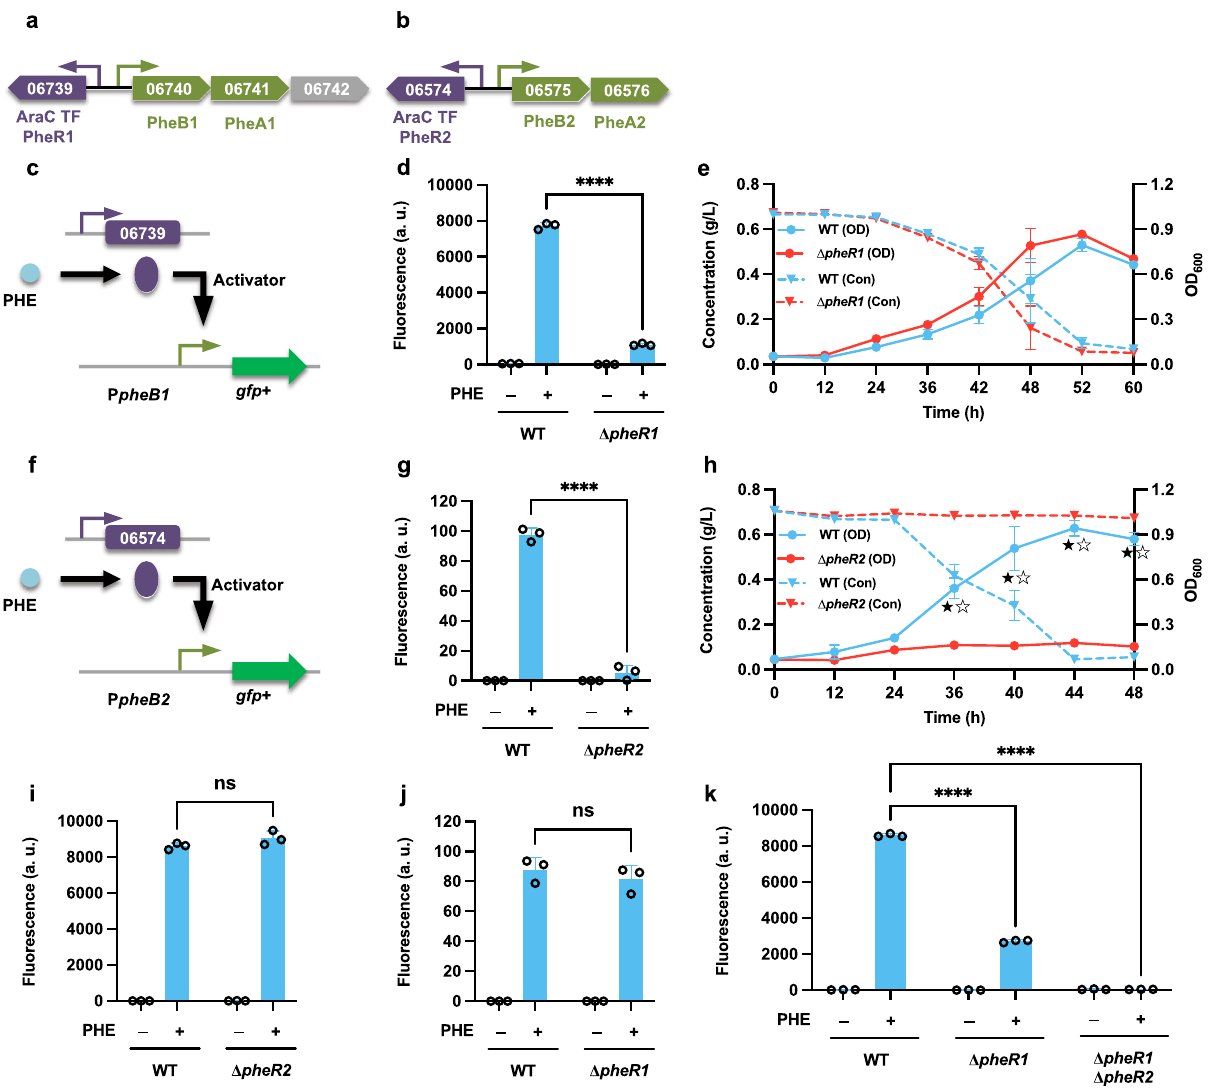
Fig. 1 Functional analysis of the phenol-responsive transcription factors pheR1 (LPD06739) and pheR2 (LPD06574). The R. opacus PD630 genome contains two phenol degradation operons, depicted in a , b ; the schematics include the promoters (small arrows) and proposed corresponding transcription factors (TFs), with operon genes indicated by LPD gene numbers corresponding to the NCBI database (Refseq, CP003949.1). For the full annotations of the pathway genes, see Supplementary Table 1. c , f To analyze the function of the proposed transcription factors pheR1 and pheR2 in regulating these operons, the transcriptional constructs P pheB1 -GFP + and P pheB2 -GFP + were expressed in WT and the corresponding TF deletion mutant strains. d , g The normalized fl uorescence of the WT and Δ pheR1 and Δ pheR2 was measured with and without supplemental phenol (PHE) (****, P < 0.0001, unpaired two- tailed t test). e , h Comparisons of cell growth (OD) and phenol consumption (Con) between WT and the two TF deletion mutant strains Δ pheR1 and Δ pheR2 when fed 0.7 g/L PHE as the sole carbon source; cell growth and phenol consumption were signi fi cantly reduced in the Δ pheR2 strain ( ★ , P < 0.05 for OD; ☆ , P < 0.05 for Con; two-tailed mixed model ANOVA with Sidak ’ s multiple comparisons). i , j The transcriptional activity of the promoter P pheB1 in the mutant Δ pheR2 and the transcriptional activity of the promoter P pheB2 in the mutant Δ pheR1 . Measurements were conducted with and without supplemental PHE (ns, not signi fi cant, unpaired two-tailed t test). k Comparison of the transcriptional activity of the promoter P pheB1 in the different knockout strains when treated with and without supplemental PHE (****, P < 0.0001, unpaired two-tailed t test). For all fl uorescence assays, cell cultures contained 1 g/L glucose with ( + ) or without ( − ) 0.3 g/L PHE as the carbon source; all the fl uorescence values were determined in the early stationary phase and normalized to an optical density at 600 nm (OD 600 ). All values represent the mean of triplicate cultures, with error bars depicting the standard deviation from that